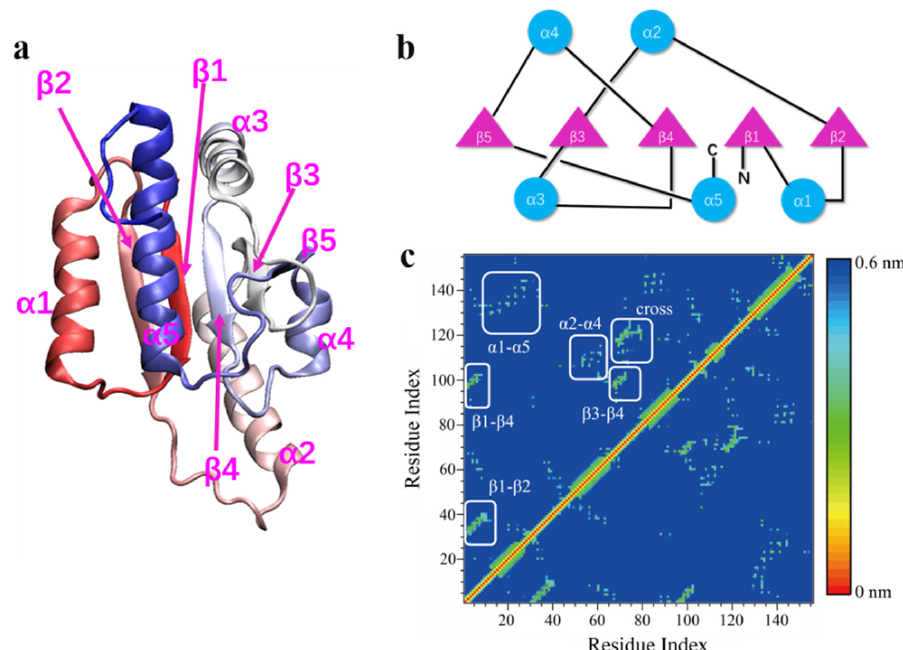
Figure 1. Structural analysis of the monomeric YbeA used in our simulations. ( a ) Equilibrium structure of the monomeric protein with a color gradient from N-terminal (red) to C-terminal (blue). ( b ) Topological diagram showing relative positions and connections of different domains and how the knot is formed. ( c ) Contact map of the monomeric YbeA, which was plotted according to the shortest distance between each pair of residues inside the protein.